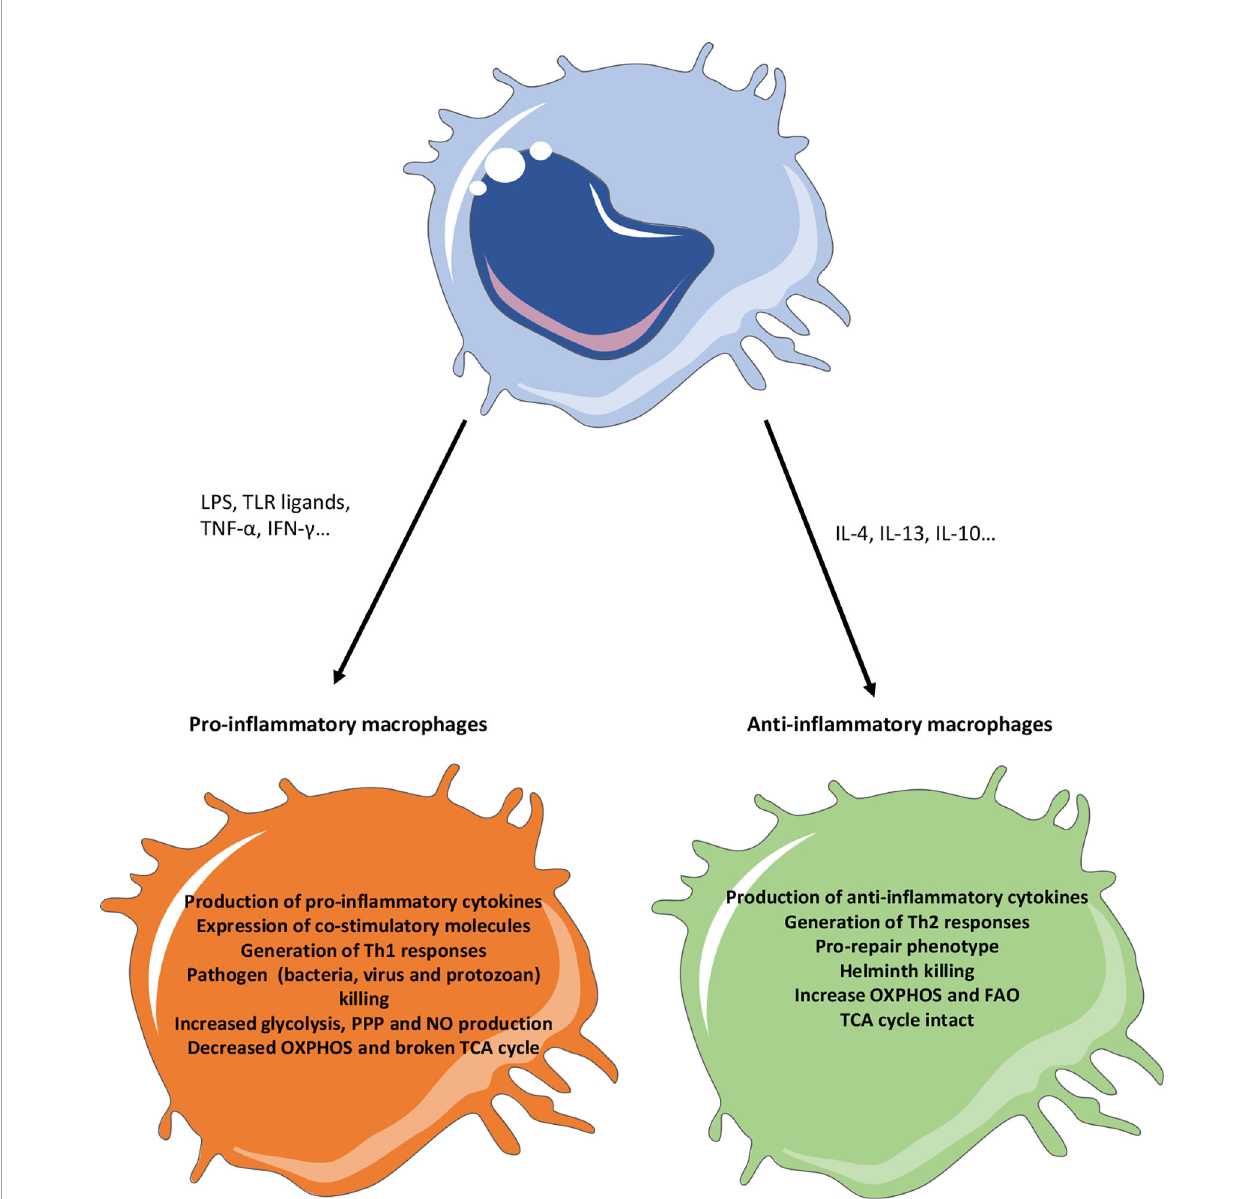
FIGURE 2 | Phenotypic characteristics of pro- versus anti-in fl ammatory macrophages. Pro-in fl ammatory stimuli (like TLR ligands or pro-in fl ammatory cytokines) will generate a pro-in fl ammatory response in macrophages, notably characterized by the production of pro-in fl ammatory cytokines, the expression of co-stimulatory molecules and a Th1 response. On the other hand, anti-in fl ammatory stimuli (like IL4, IL13 or IL10) will promote a pro-repair phenotype in macrophages notably caracterized by the production of anti-in fl ammatory and pro-resolutive factors and the generation of a Th2 response. In the context of infection, the generation of pro-in fl ammatory macrophages will promote their killing activity but microbes will try to promote the generation of anti-in fl ammatory phenotype to escape these responses. Anti-in fl ammatory macrophages, while promoting infections in general, will have a strong anti-helminth effect. Metabolically, the pro-in fl ammatory macrophages use glycolysis and PPP to produce energy and have a broken TCA cycle. Instead, anti-in fl ammatory macrophages use the FAO and OXPHOS to provide cellular energy. FAO, Fatty acid oxidation; IFN, Interferon; IL, Interleukin; LPS, Lipopolysaccharide; OXPHOS, Oxidative phosphorylation; NO, Nitric oxide; PPP, Pentose phosphate pathway; TCA, Tricarboxylic acid; Th, T helper; TLR, Toll like receptor; TNF a , Tumor necrosis factor